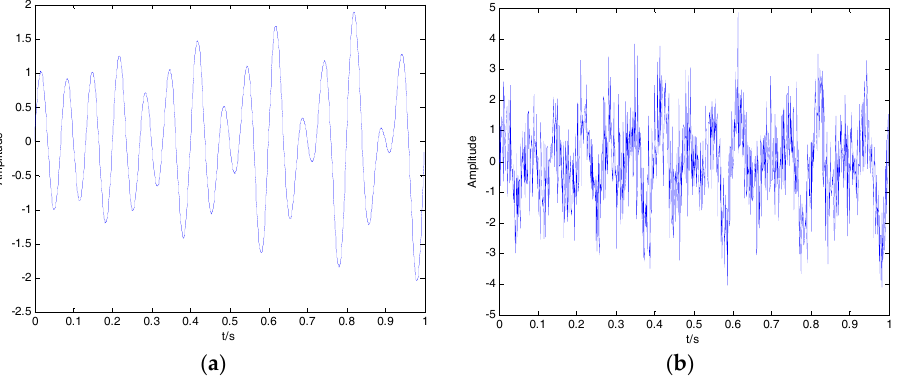
Figure 9. ( a ) The clear signal; ( b ) the noisy signal.